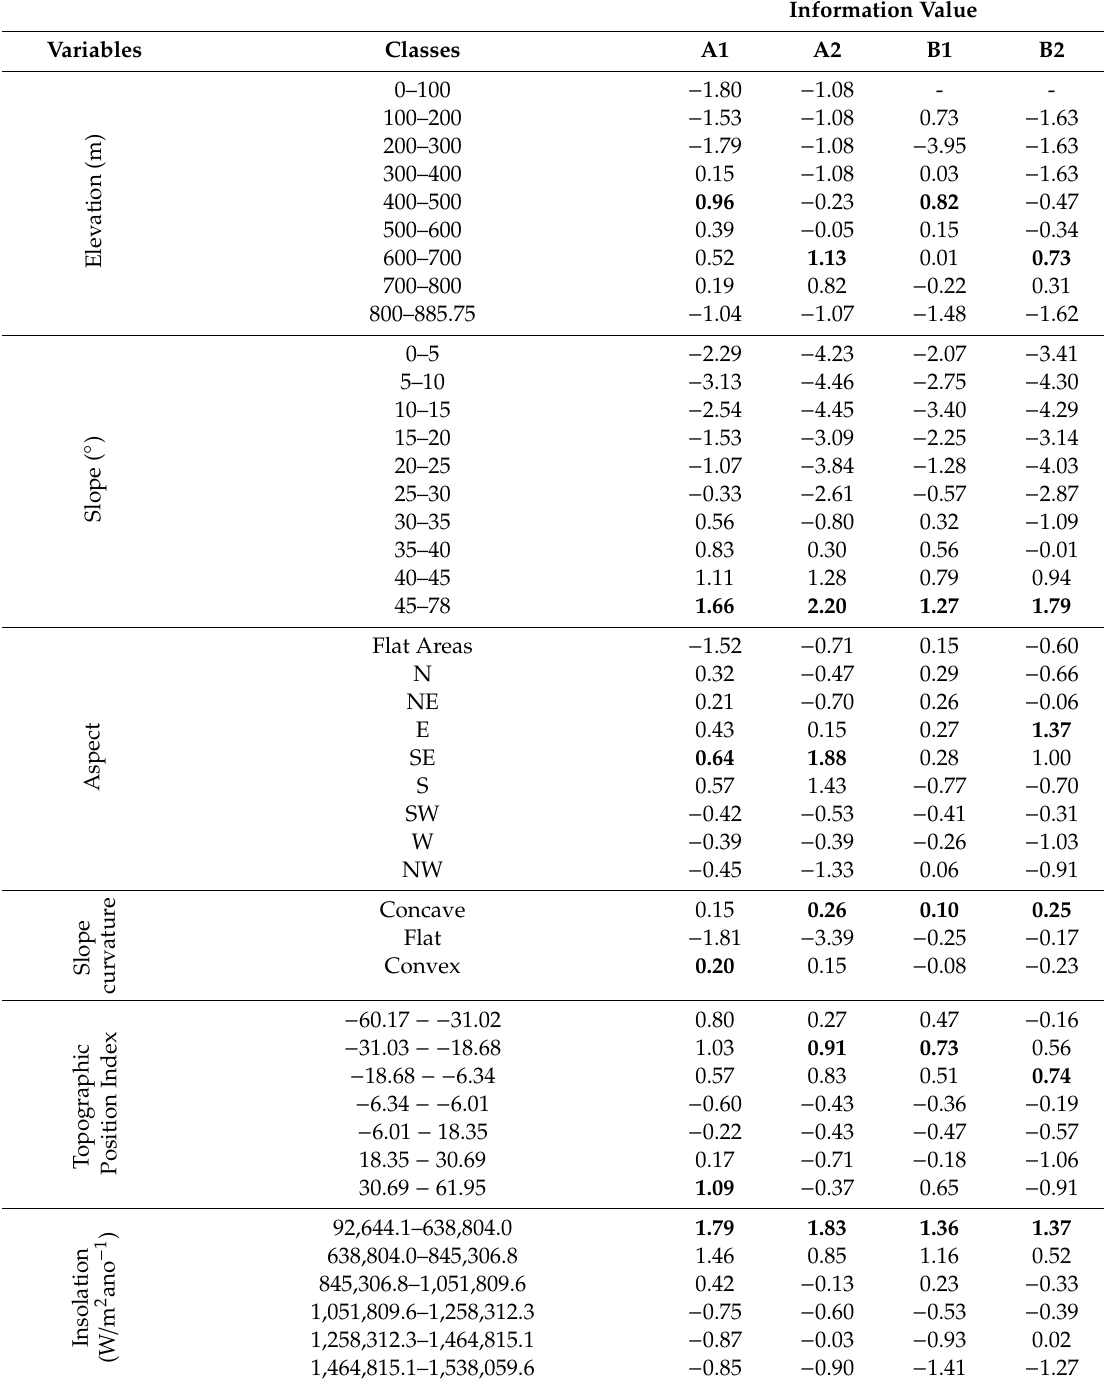
Table 2. Information Value (IV) scores determined for each class of each predisposing factor. The highest scores are highlighted in